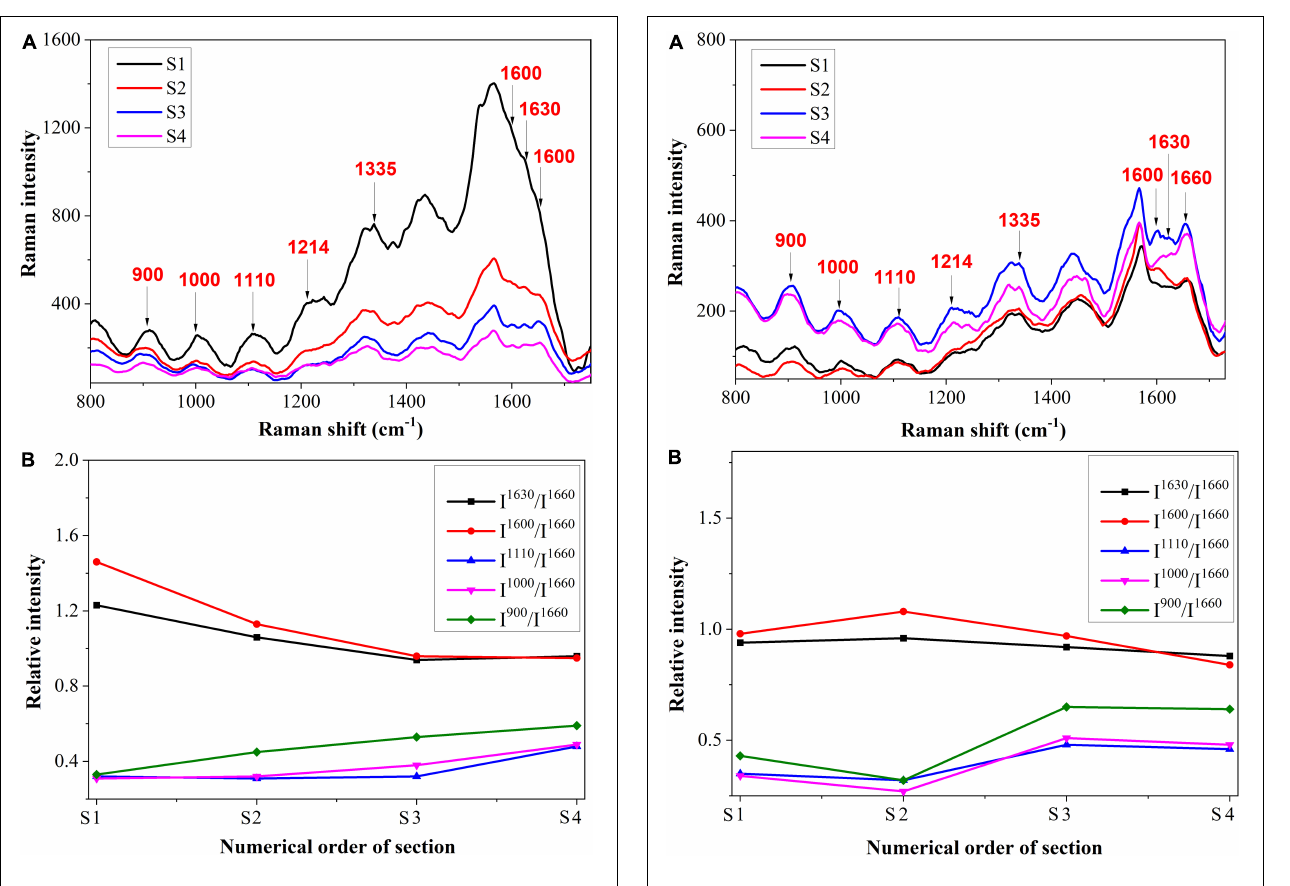
Raman Chemical Imaging